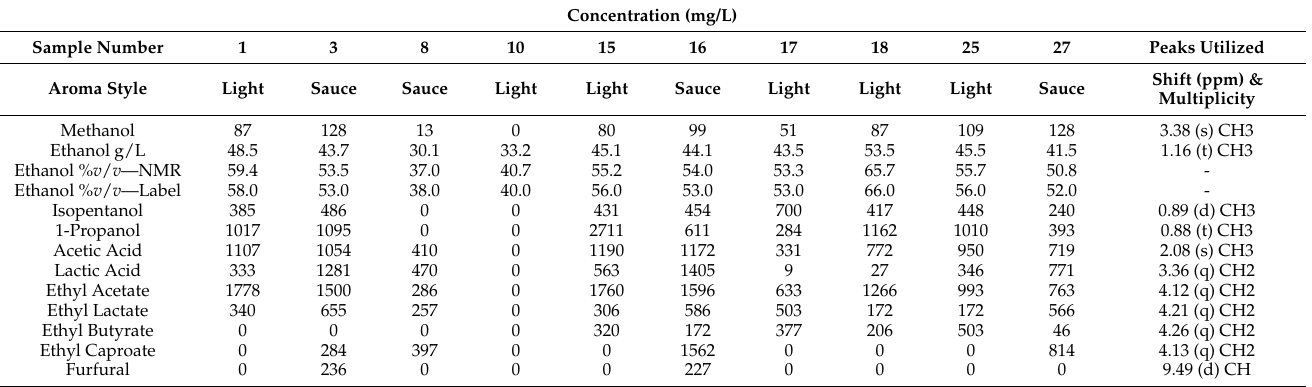
Table 2. Concentrations of ethanol and major congeners for 10 of the 30 baijiu samples